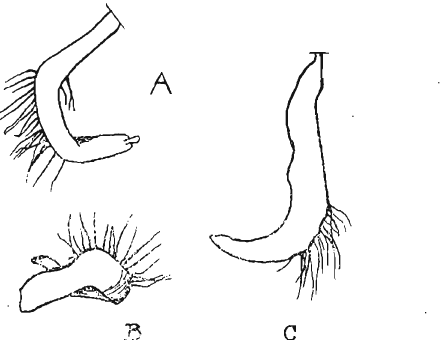
Fig. 1. Male genital claspers of Orthotylns delicatus Cook. A, right clasper, dorsal as- pect; B, right clasper, lateral aspect; C, left clasper, dorsal aspect.